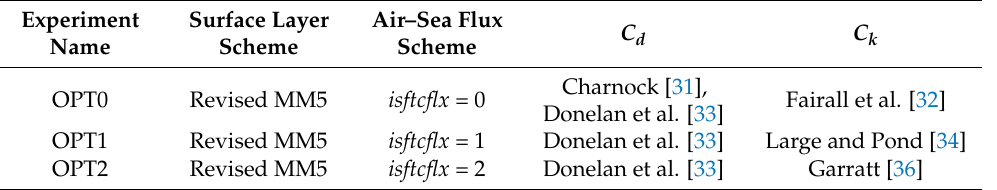
Table 1. Brief description of the sensitivity numerical